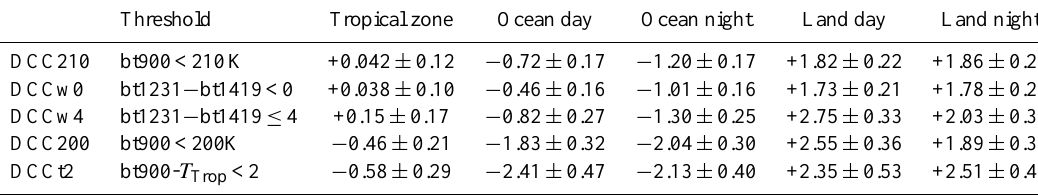
Table 3. Summary of trends and trend uncertainties in %yr − 1 units.